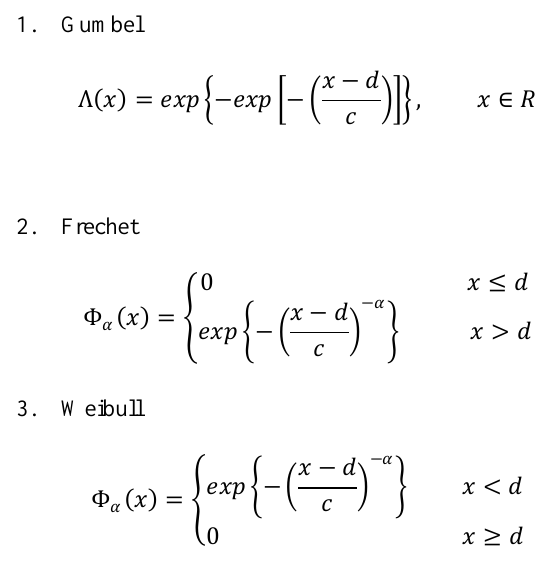
Fig. 4. Chronologically arranged the insured losses of natural catastrophes in USD million.